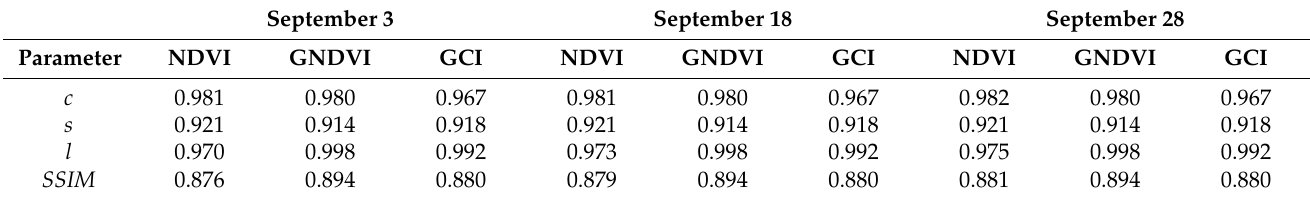
Table 6. Similarity of NDVI, GNDVI and GCI images obtained from merging the original August and original September images during the overlapping